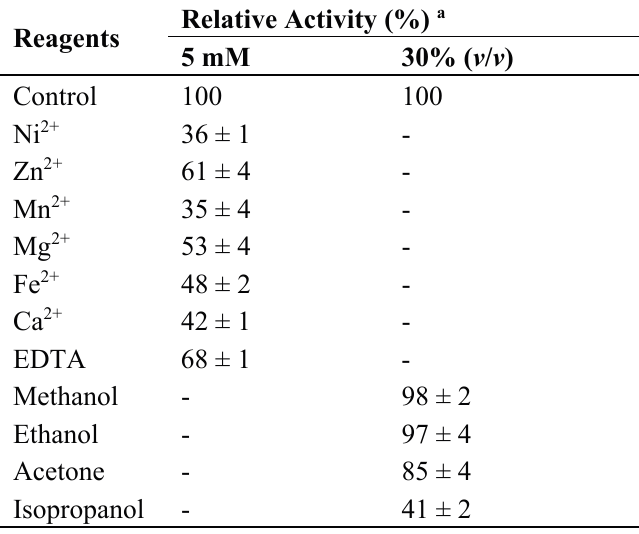
Table 1. Effects of various reagents on Mg MDL2 activity.